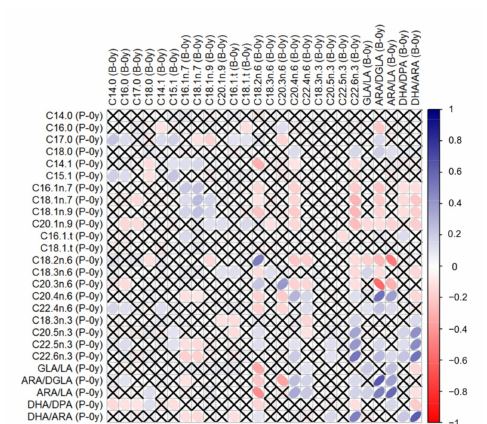
Figure 1. Correlations between GPL-FA levels measured in umbilical plasma (P-0y) and buccal cells at birth (B-0y). Tested by Spearman’s ρ . White-to-blue: increasing ρ (positive correlation); white-to-red: decreasing ρ (negative correlation). (cid:53) = no significant